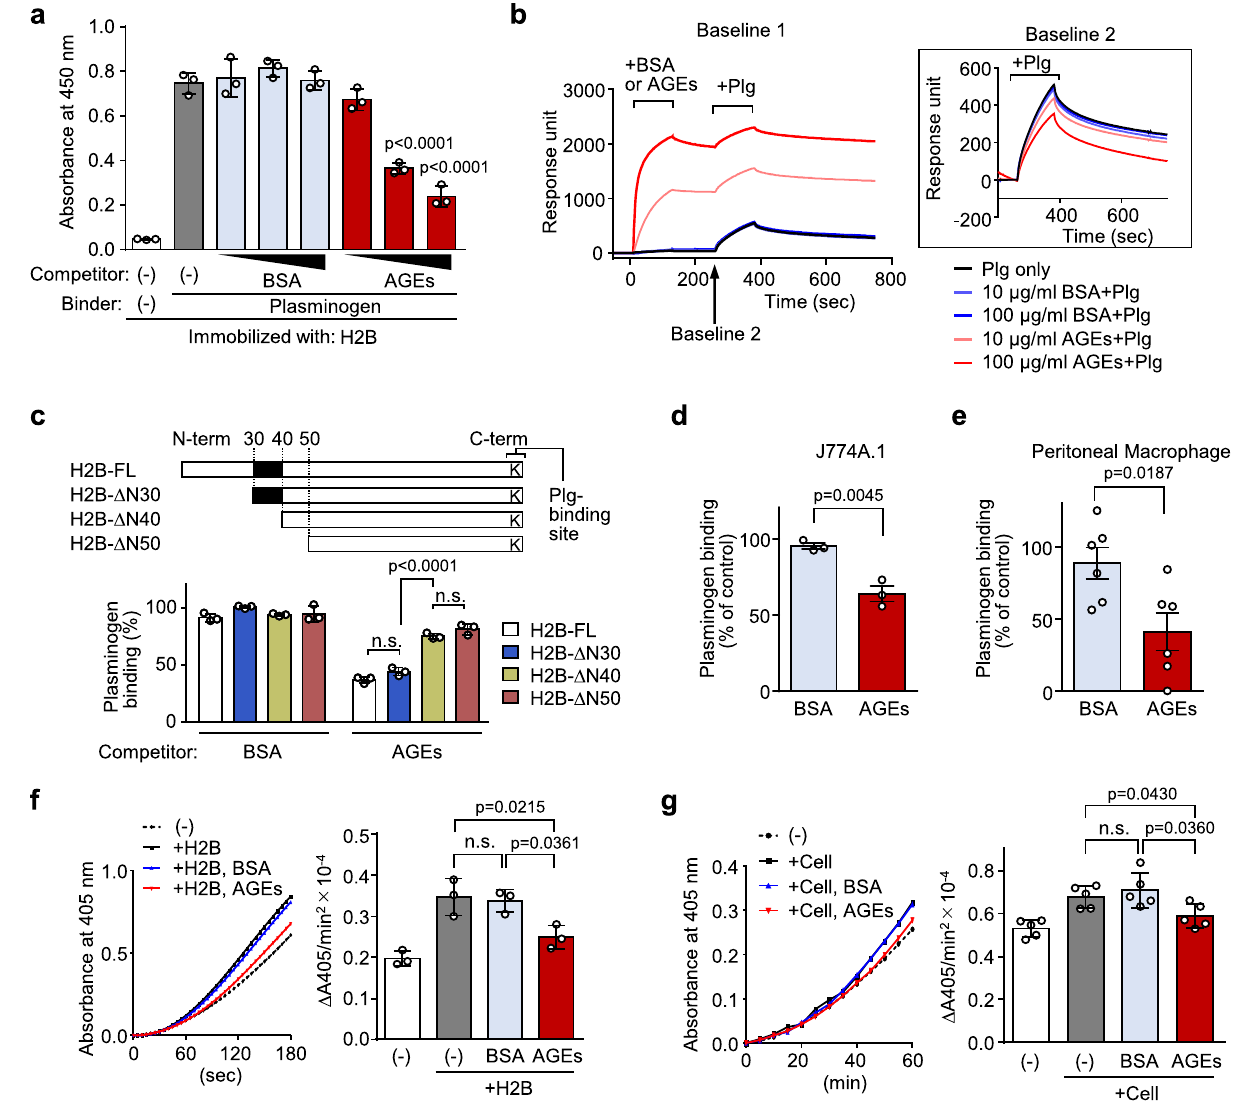
Fig. 4 AGEs inhibit Plg binding to histone H2B and macrophages. a Effect of AGEs on Plg binding to histone H2B in vitro. Recombinant H2B coated on ELISA plate was preincubated with either BSA or AGEs (1, 10, and 100 µ g/ml), followed by treatment with Bt-Plg (1 µ g/ml). Plg binding to H2B was detected with streptavidin-HRP. Data are mean ± S.D. of triplicate samples (representative of three independent experiments). Dunnett ’ s test (two-sided), relative to the treatment with Plg alone. b Surface plasmon resonance measurements. The interactions of Plg (10 µ g/ml) with H2B immobilized on a Biacore sensor chip NTA, following the addition of either BSA or AGEs (10 or 100 µ g/ml) were monitored. c Schematic representation of full length and deletion mutants of H2B (upper panel) and effects of AGEs on Plg binding to deletion mutants of H2B (lower panel). H2B mutants coated on ELISA plate were preincubated with either BSA or AGEs (100 µ g/ml), followed by treatment with Bt-Plg (1 µ g/ml). Plg binding to H2B mutants was detected with streptavidin-HRP. The absorbance value in the absence of competitor was de fi ned as 100% Plg binding. Data are mean ± S.D. of triplicate samples (representative of three independent experiments). Student ’ s t test (two-sided), n.s. not signi fi cant ( p > 0.05). d Effect of BSA or AGEs on Plg binding to